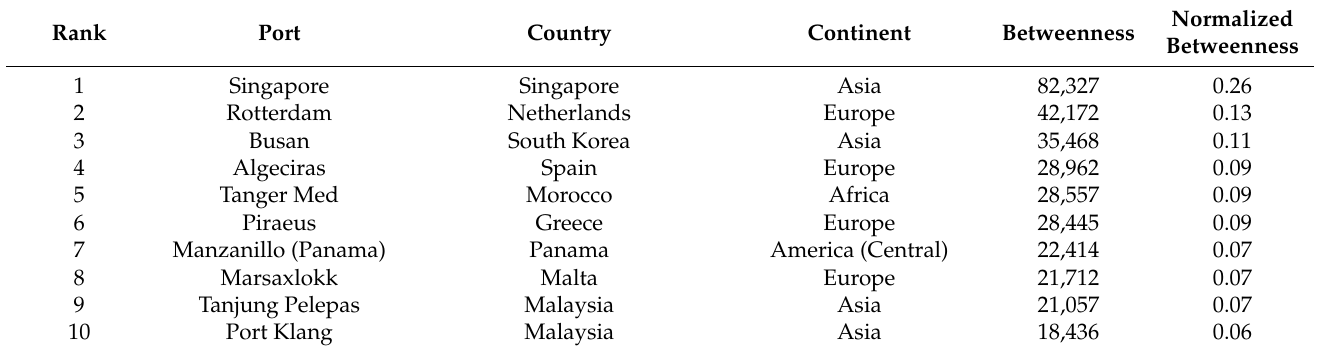
Figure 6. Communities detected in GLSN. Nodes are represented in their real coordinates (7 out of 564 ports that were not strongly connected to the major component of the GLSN are excluded). Figure 6 shows the global spatial distribution of the ports belonging to each of the 10 communities described in Table 5 as communities C1 to C10. The number of ports in the top 6 communities accounted for 82.45% of the total number of ports. C5 had the highest average degree at 6.00, the second highest average clustering coefficient at 0.44, and the third shortest path at 2.54; it performed the best in the 3 indicators among the top 6 biggest communities.